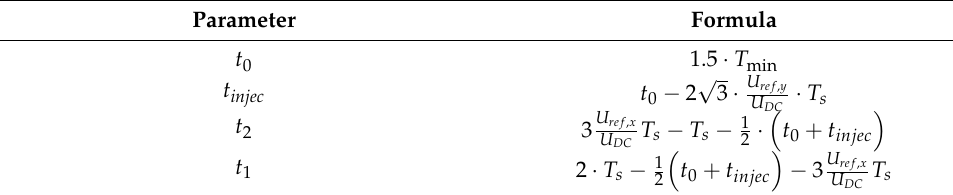
Table 9. Time calculation for the proposed SVM pattern for Region 3 applied inside the outer hexagon.